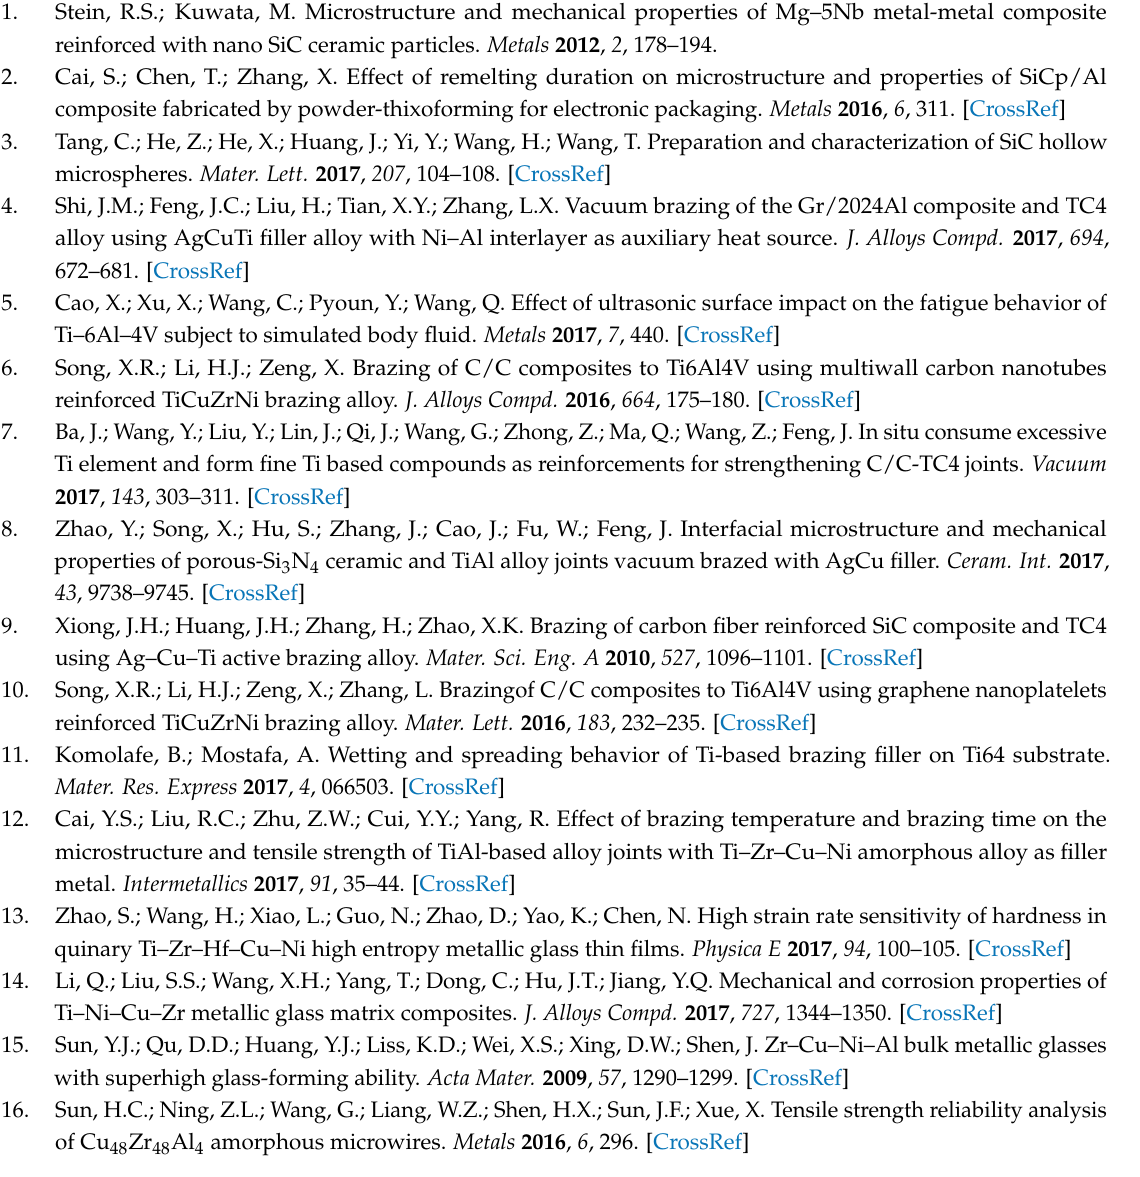
The supercooled phase region width ( ∆ T x max = 60 ◦ C), the reduced glass transition temperature ( T rg max = 0.5554), the parameter γ ( γ max = 0.3150) for inferring the relative glass-forming ability of the amorphous alloys, and the wetting area (4.64 cm 2 ), reach their maximum values, and the liquidus temperature ( T l min = 932 ◦ C) reach its minimum value when the Si content is up to 0.5%. 5. In the same brazing technology conditions, the shear intensity of the brazing joints is the highest when using the filler metal TA–Si 0.5% (102 MPa), being 122% higher than that obtained when using the filler metal TA–Si 0% (46